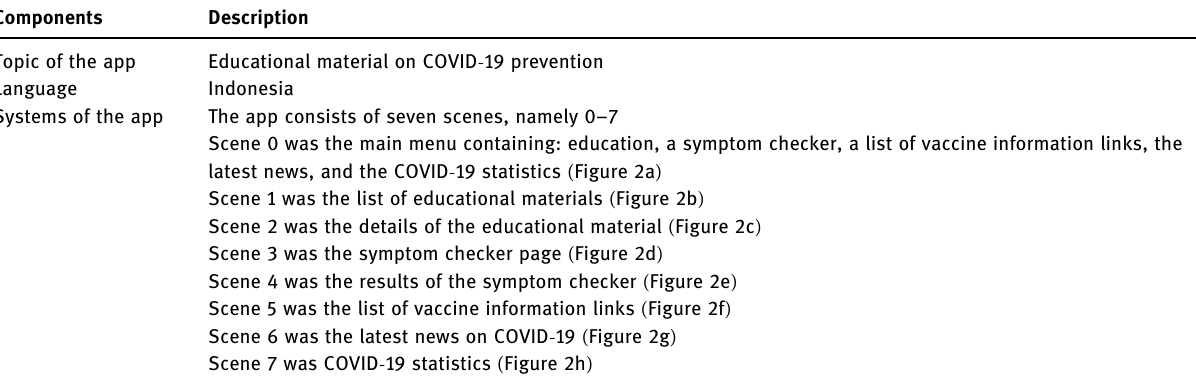
Table 3: Description of the